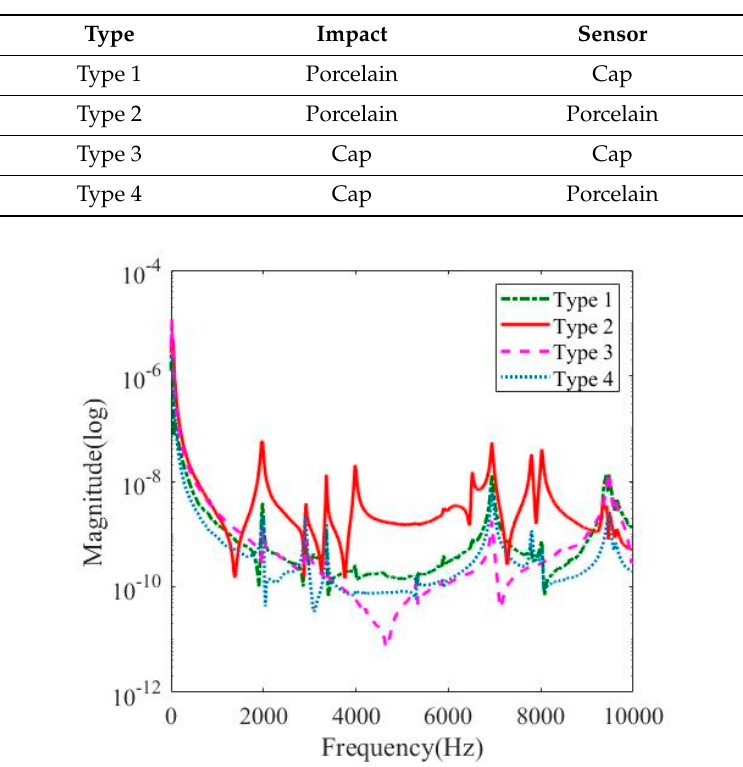
Figure 3. Frequency response function (FRF) results according to impact and sensor position.